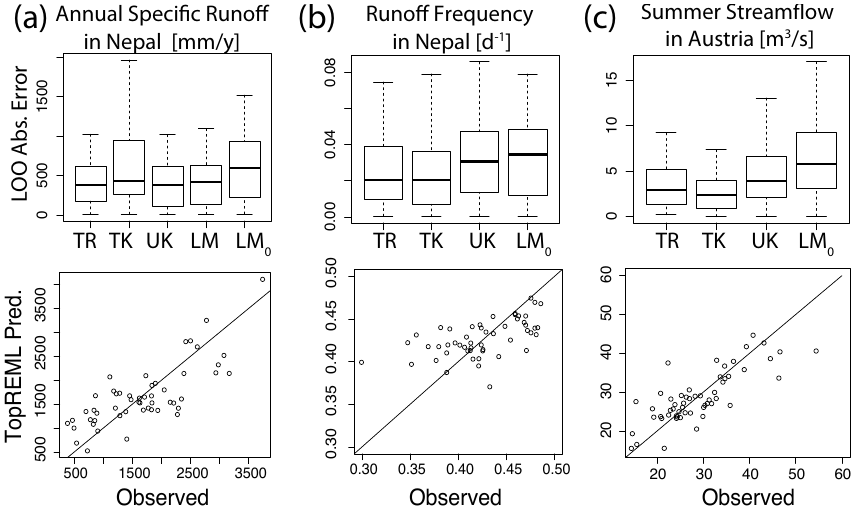
Figure 5. Results of the comparative cross-validation analyses of (a) specific runoff and (b) wet season runoff frequency in Nepal, and (c) mean summer streamflow in Austria. First row: box plots with the quartiles and 95% confidence intervals around the median of leave-one-out (LOO) absolute prediction errors. Compared models are TopREML (TR), Top-kriging (TK), universal kriging (UK), linear regression models (LM) and the sample mean (LM 0 ). Note that without observable trends ( b and c ), LM and LM 0 are equivalent. Second row: catchment level performance of TopREML. Signatures predicted by TopREML for each catchment in the leave-one-out cross-validation analysis are plotted against the corresponding observed signature. Diagonal lines ( x = y ) representing perfect fit are also displayed for indicative purposes.